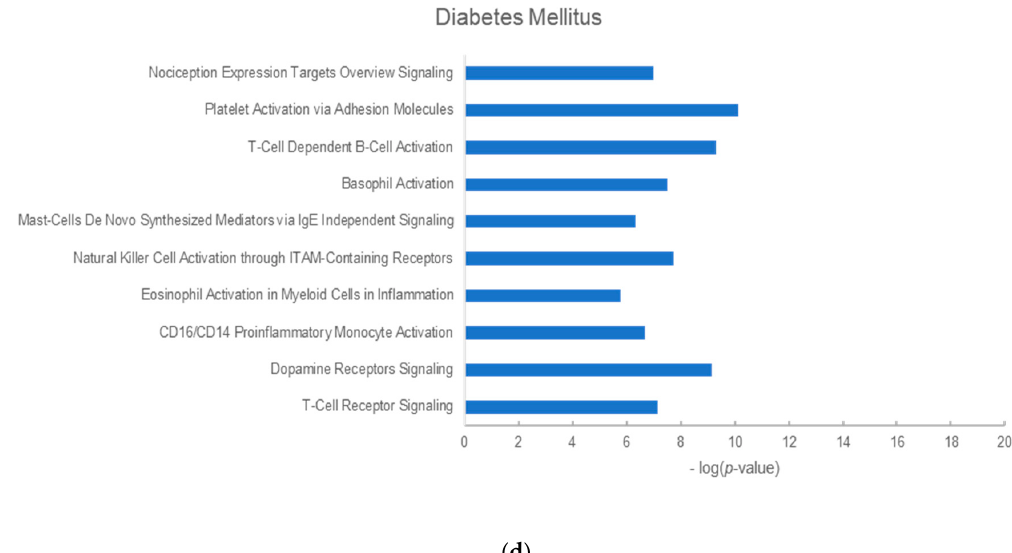
Figure 3. Top 10 enriched pathways of red ginseng in metabolic diseases. ( a ) Menopause symptoms. ( b ) Blood circulation. ( c ) Hyperlipidemia. ( d ) Diabetes mellitus. The y-axis shows the significantly enriched pathways of the targets and the x-axis shows the enrichment scores of the terms ( p < 0.05).